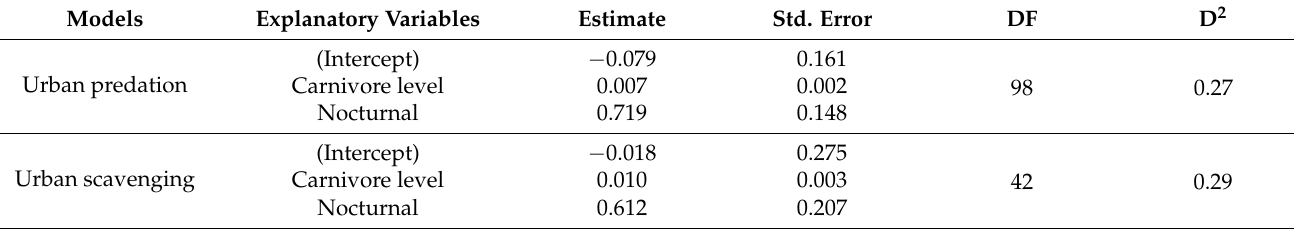
Table 4. Results of the General Linear Models (Poisson error distribution and identity linkage) selected to explain the number of studies in which each species appears. The estimate of the parameters (including the sign), the standard error of the parameters, the degrees of freedom of the models (DF) and variability explained by the models are represented (D 2 ).